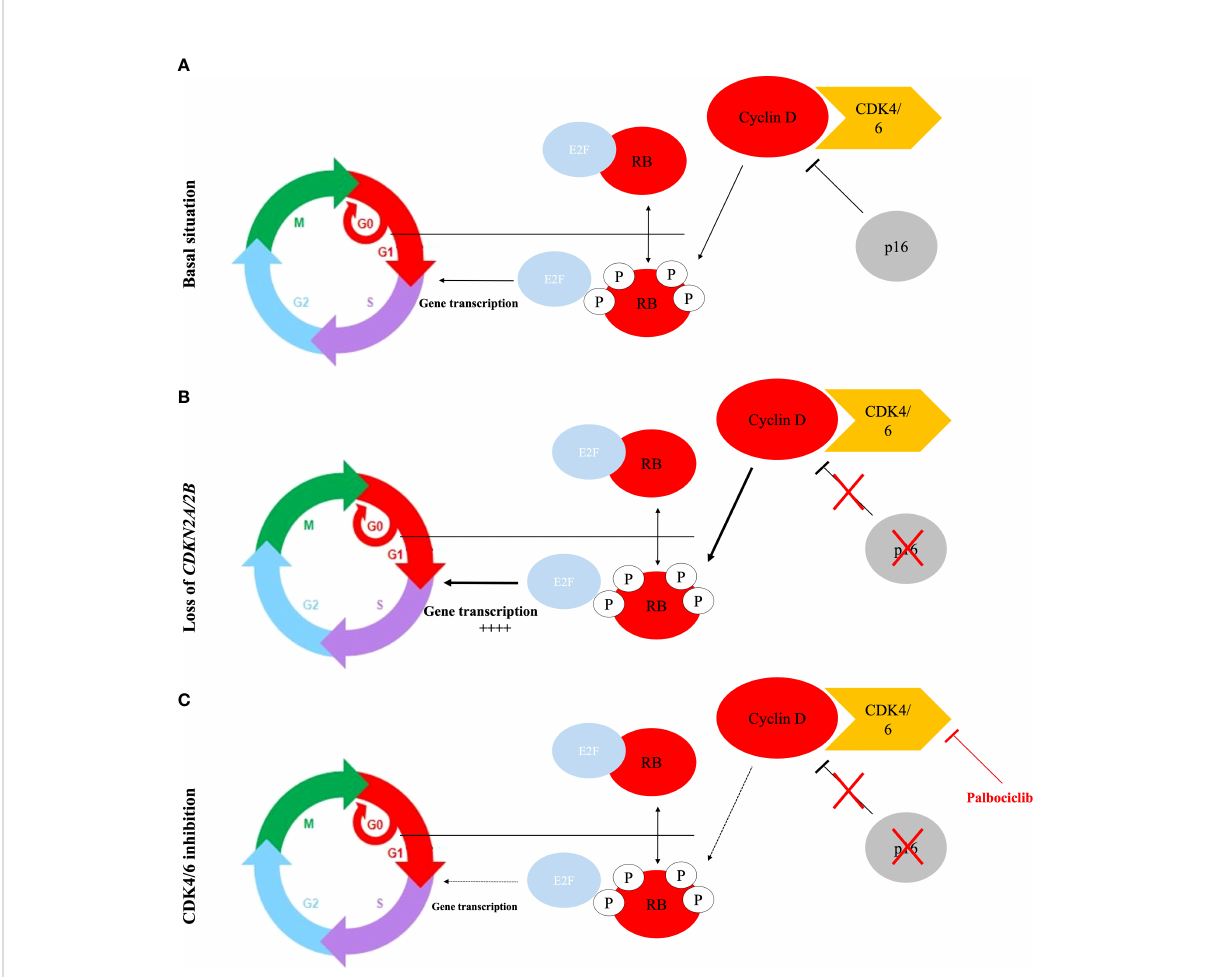
FIGURE 6 The classic model for the regulation of the G1/S transition by cyclins and CDK. (A) In basal situation, RB protein phosphorylation performed by cyclin D-CDK4/6 kinase induces E2F releasing and facilitates the expression of E2F target genes, which are critical for initiation of DNA synthesis and entry into S-phase. CDK4/6 activity is repressed by the p16 protein. (B) Loss of p16/CDKN2A/2B activity leads to an overactivation of the CDK4/6 activity and therefore an uncontrolled cell proliferation. (C) The CDK4/6 inhibitor re-establishes the activity of the RB protein activity as an inhibitor of cell